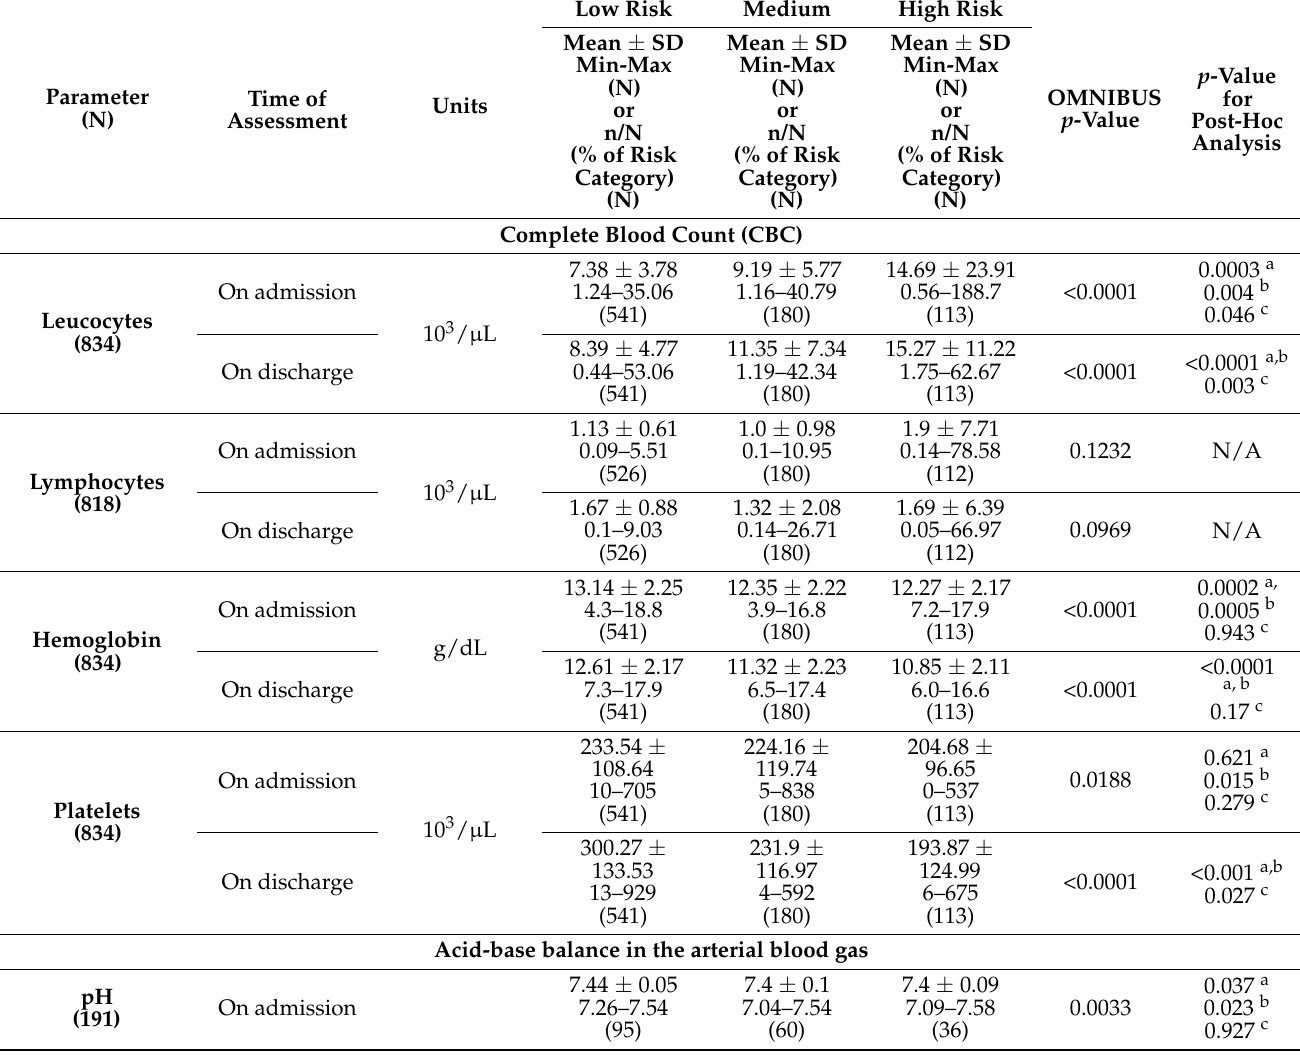
Table 4. Laboratory parameters measured during the hospitalization in the studied